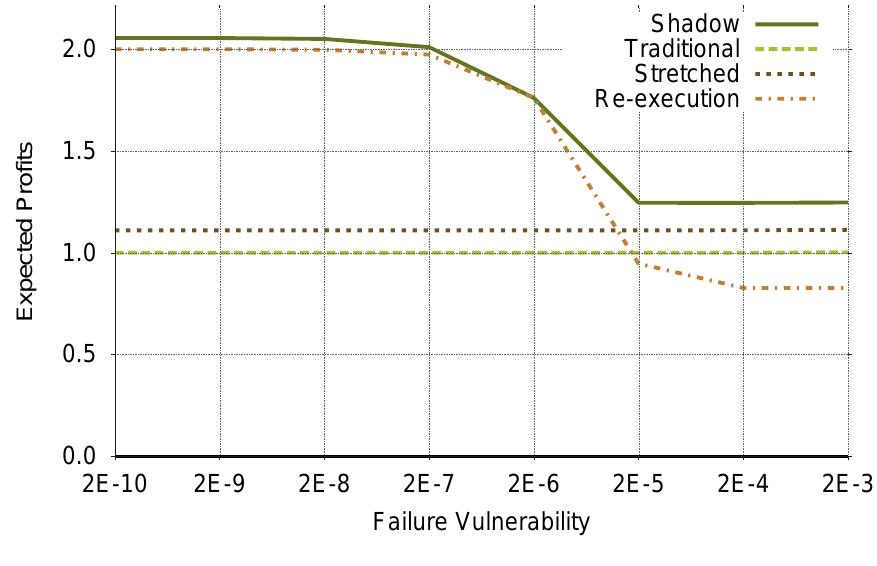
Figure 6. Profit for different task size over MTBF. ρ = 0.5, N = 100,000, t t = 2.6 h. R 2